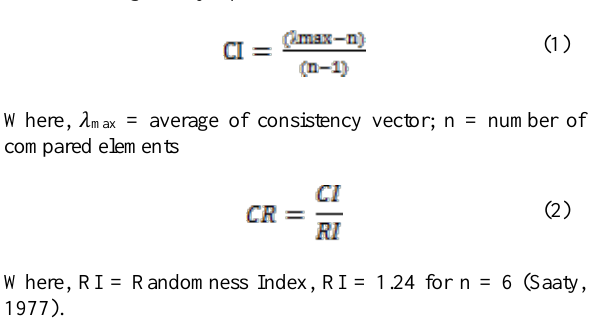
Table 10. Normalized Matrix Consistency Index (CI) is given by equation 1 and Consistency Ratio (CR) is given by equation